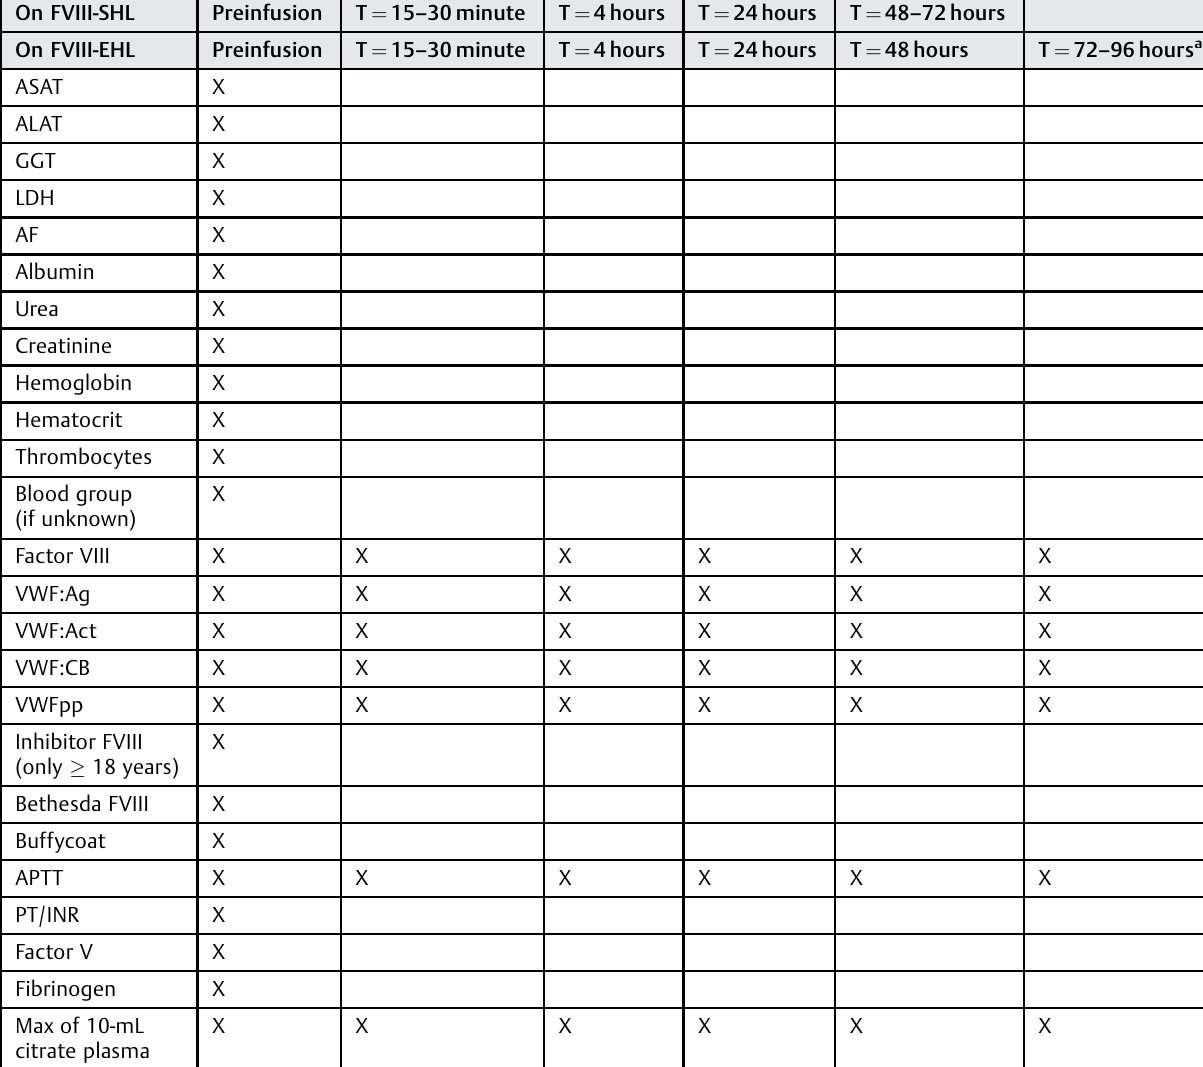
Table 1 Laboratory tests during individual PK pro fi ling for patients with hemophilia A On